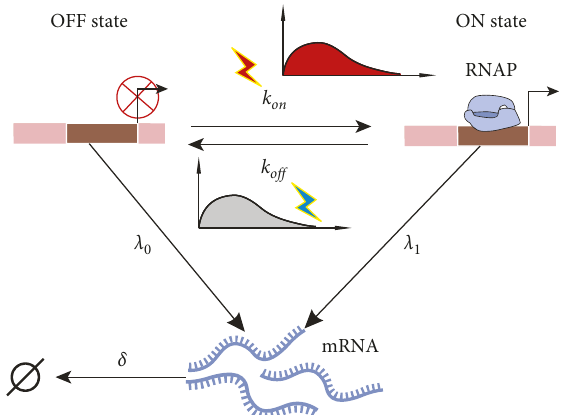
Figure 1: Schematic illustration of the two-state gene model stimulated by the extracellular signals (OU process whose sta- tionary distribution obeys a gamma distribution, red or grey distribution) regulating the activity of the promoter through transfer function under different modulation paradigms, and the transcription rate is much larger than the leakage of transcription rate ( λ ≫ λ 1 0